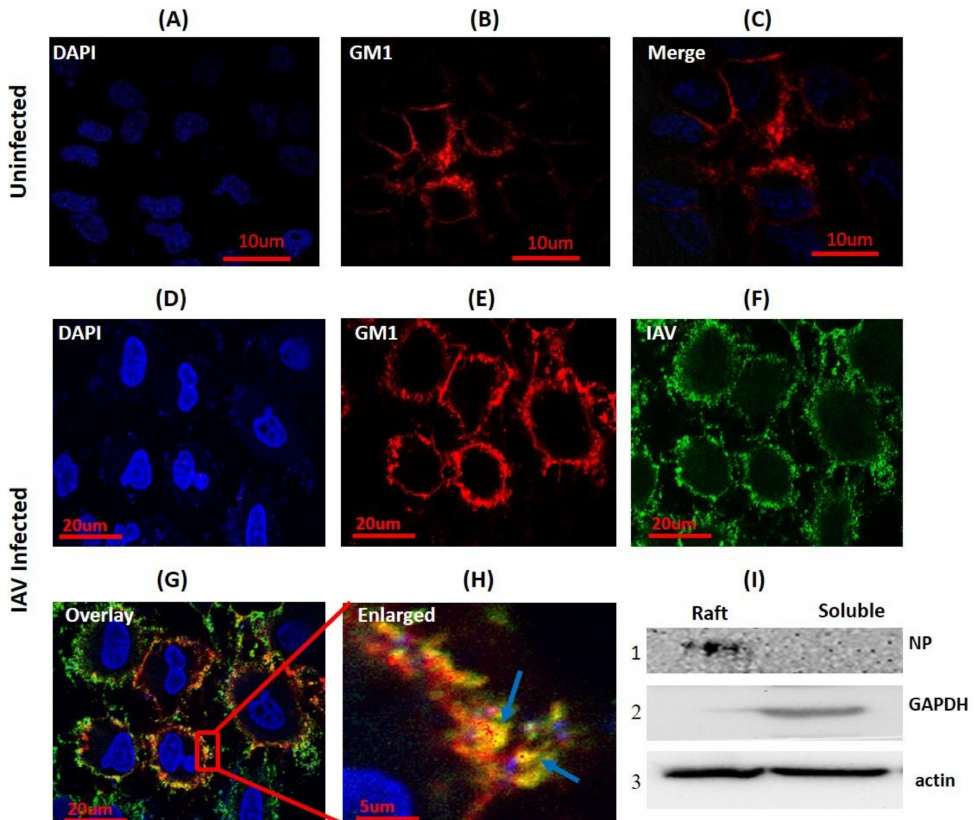
Figure 1. Influenza A virus (IAV) co-localizes with host membrane lipid rafts during binding. ( A – C ) CTB-594 stained (4 ◦ C) A549 cells (uninfected control). Patchy distribution of ganglioside 1 (GM1) (rafts) is visible (red); blue, DAPI (4 (cid:48) , 6-diamidino-2-phenylindole) nuclear staining. ( D – G ) IAV incubated (4 ◦ C) A549 cells stained with CTB-594 (4 ◦ C). Surface bound viruses were stained with anti-NP-FITC (anti-nucleoprotein-fluorescein isothiocyanate) antibody (Green). Yellow color and arrows indicate IAV co-localization with GM1; blue, DAPI nuclear staining. ( H ) Enlarged view of indicated section of image G, magnification ~3X. ( I ) Western blot of raft proteins isolated from IAV incubated (4 ◦ C) A549 cells. NP was detected in the raft fraction (I, panel 1). GAPDH (Glyceraldehyde 3-phosphate dehydrogenase) was used as cytosolic marker and beta-actin as internal